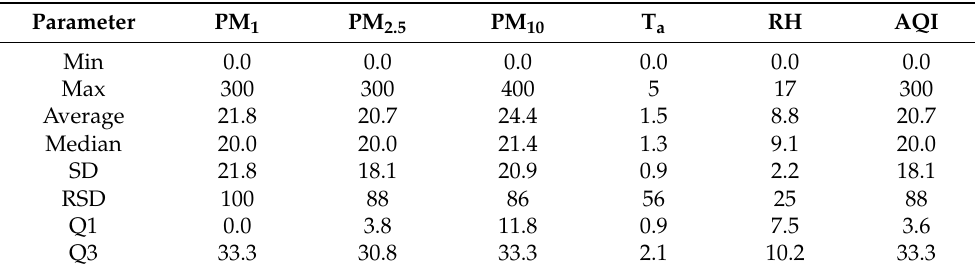
Table 2. Bias (%) for GPM sensors calculated for indoor air monitoring data recorded at the urban site (living room) between 27 and 30 May 2021 (sampling rate: 10 s, n =